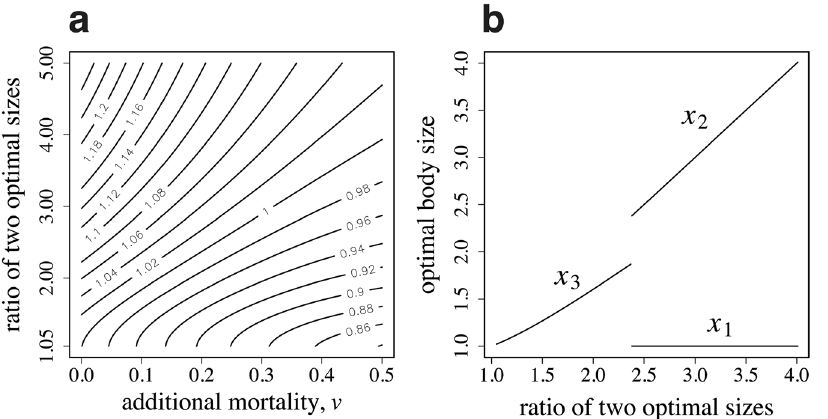
Figure 4. Age polyethism versus caste polyethism. ( a ) Contour map of the relative advantage of specialized castes to age-dependent task switching. Numbers by the contours indicate the ratio of colony performance B of caste polyethism to age polyethism. ( b ) The optimal size of workers to produce. The parameter used in ( b ) is = . v 0 2 . The other parameters are as follows: β = . 1 0 1